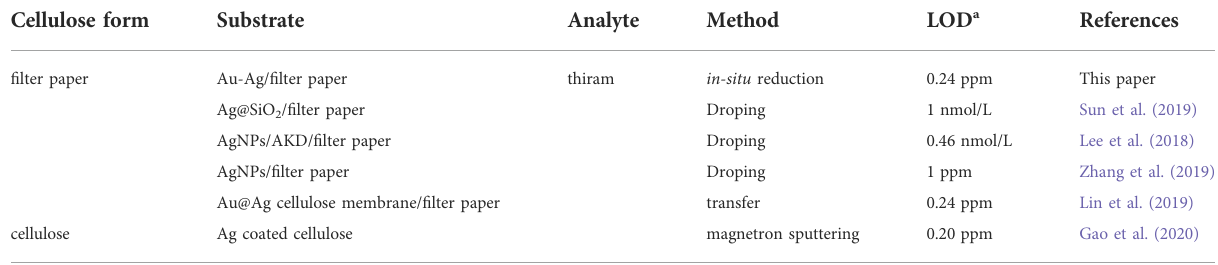
TABLE 1 Cellulose-based SERS material for food safety